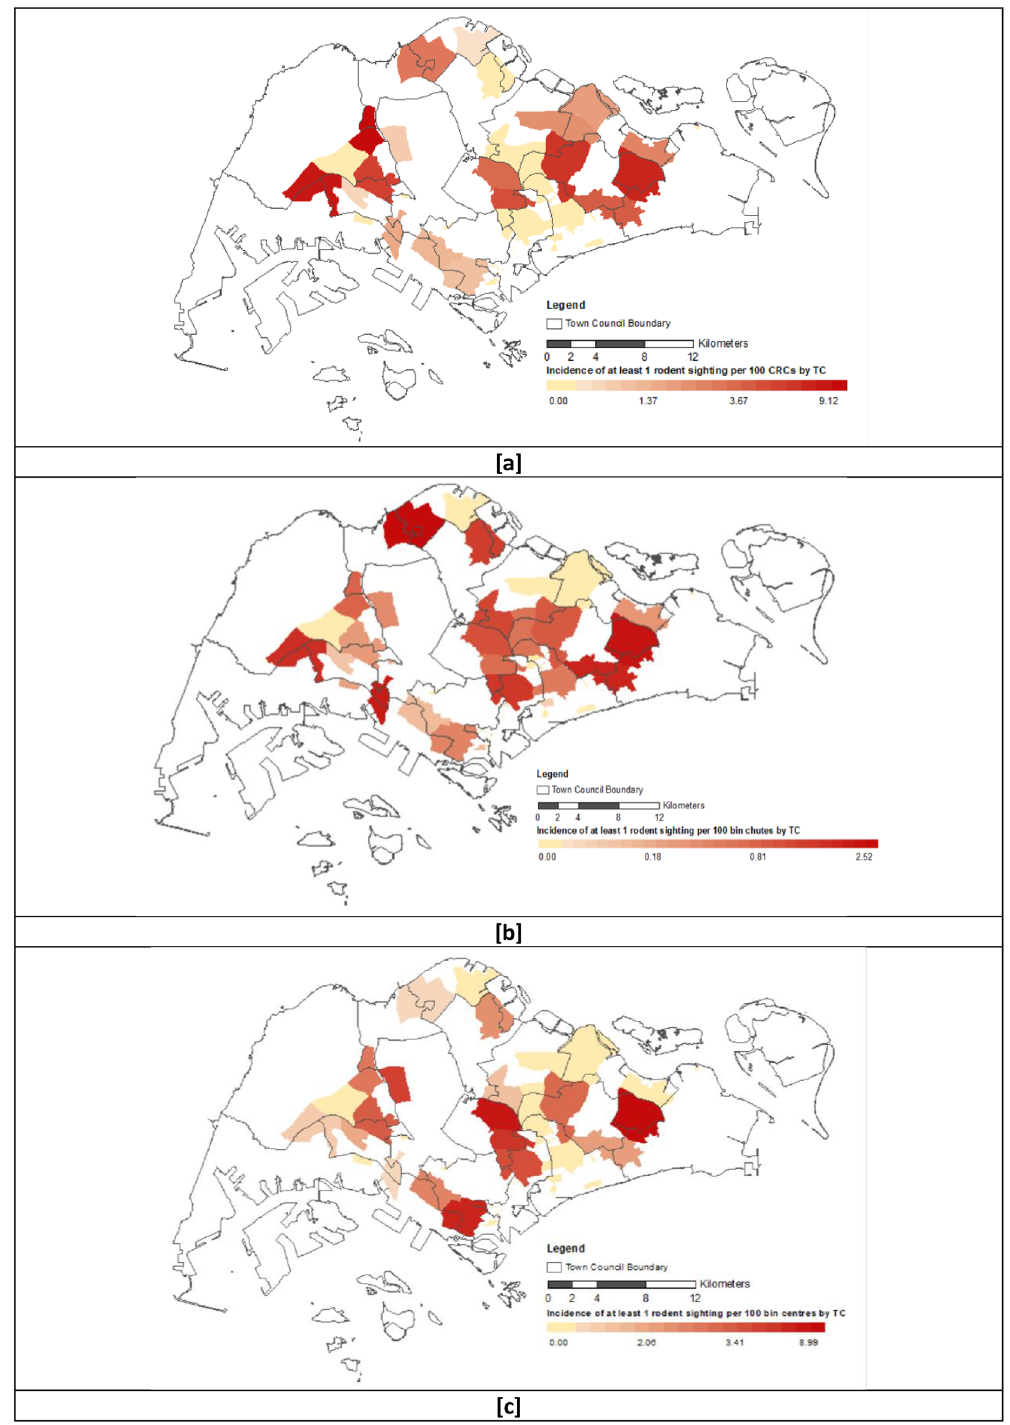
Figure 2. Spatial Incidence of Rodent Sightings in Singapore, 2019–2020. The coloured polygons represent the incidence of rodent sightings in CRCs ( a ), IRC bin chambers ( b ) and bin centres ( c ) per 100 premises in each town council-managed housing estate. The colour density is positively related to the incidence of rodent sightings 26